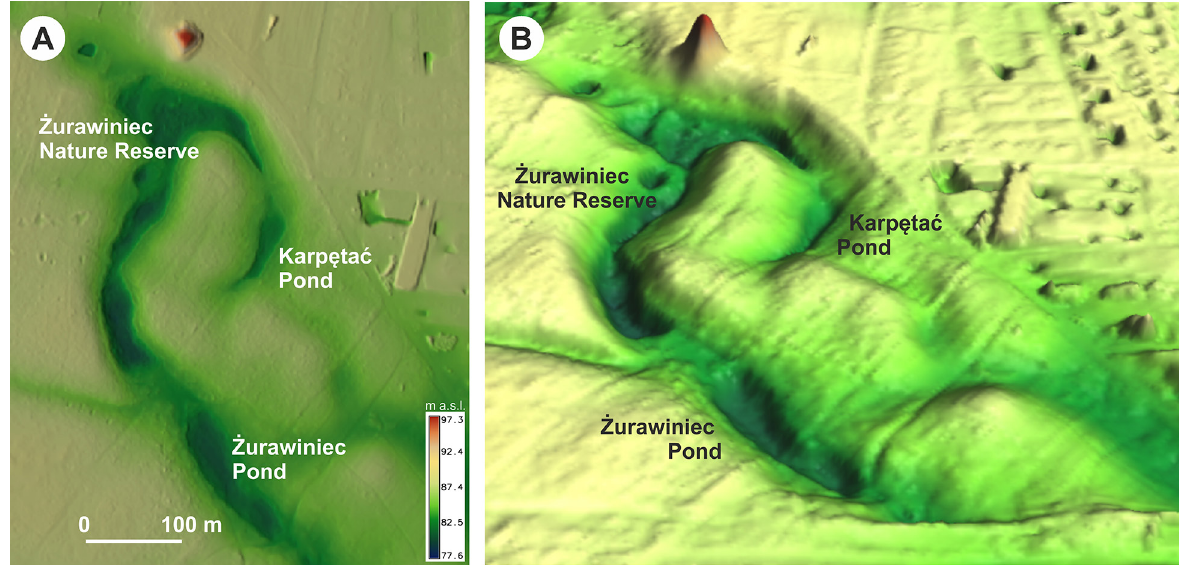
Fig. 12. digital terrain models of the Żurawiniec Reserve and its immediate vicinity (elaborated on the basis of the ISok Project by J. Jasiewicz) (after Makohonienko 2014). A – 2d model, B – 3d